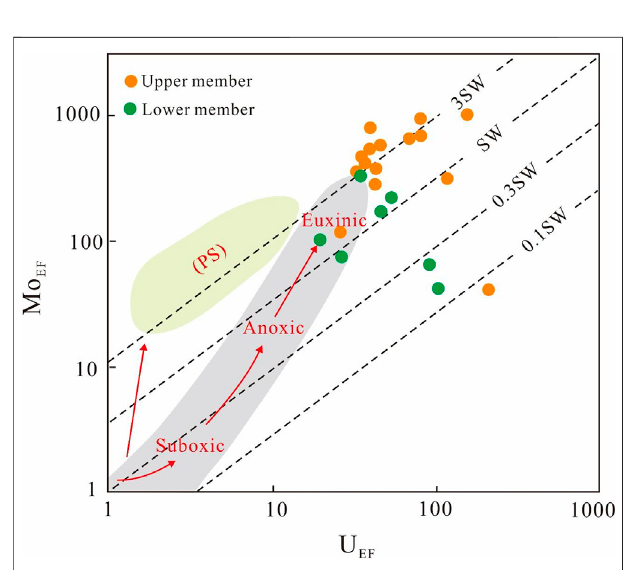
FIGURE 6 | Plot of the Mo EF versus U EF from the shale samples in the Gufeng Formation at the Putaoling section. PS = Particulate shuttle. The diagonaldottedlinesrepresentdifferentMo/U ratios ofmodernseawater(0.1, 0.3, 1, and 3).